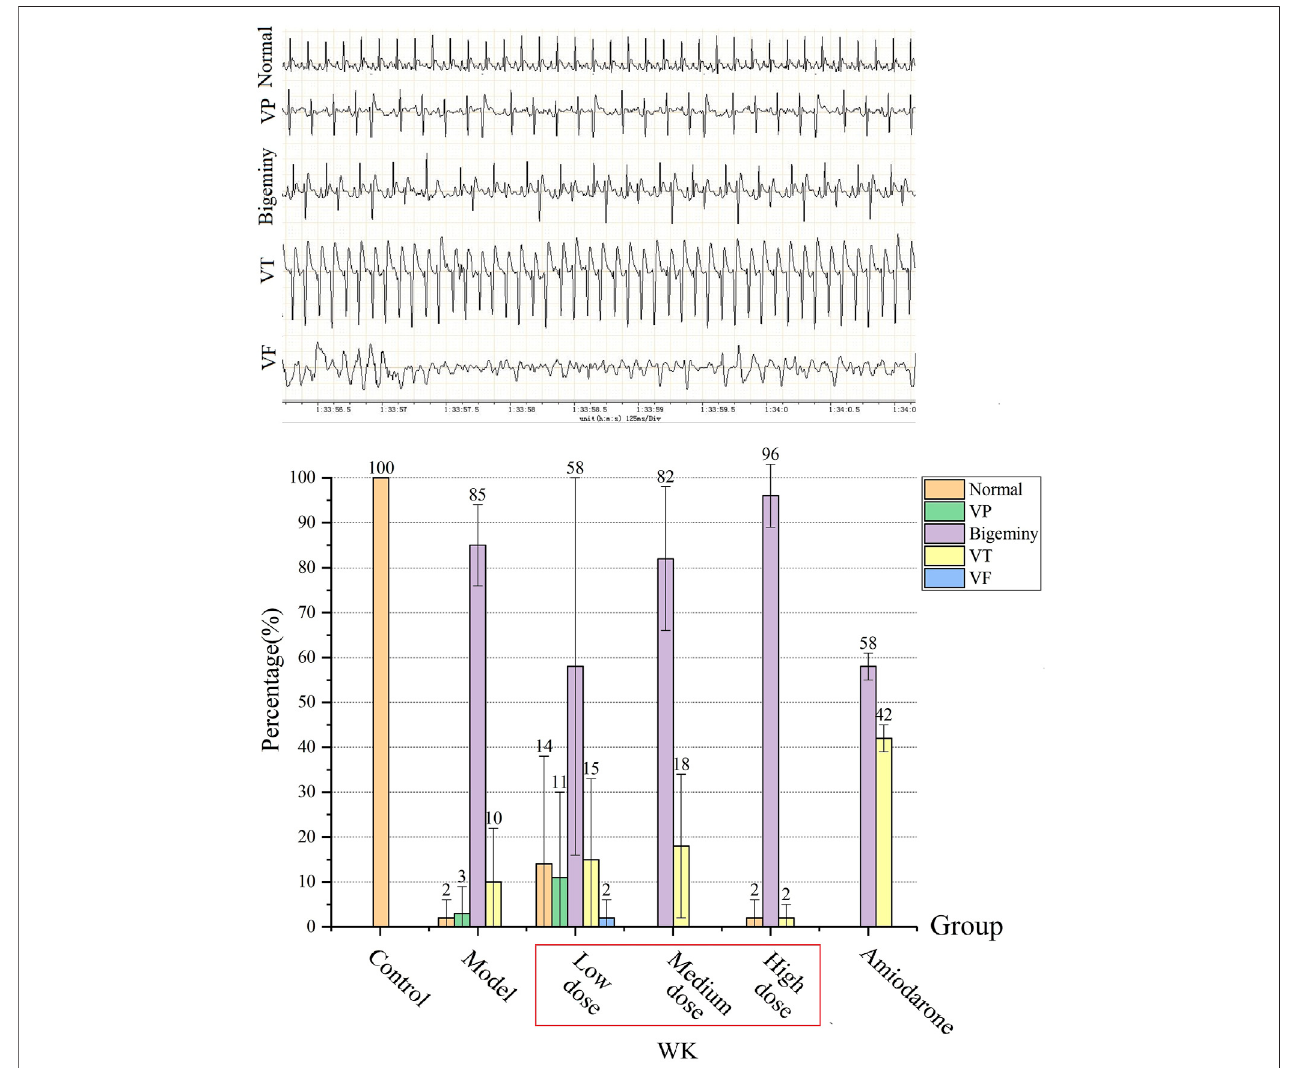
FIGURE 5 | The percentage of arrhythmias ’ duration (%) ( x ± s , n (cid:1) 8). VP: ventricular premature, VT: ventricular tachycardia, VF: ventricular fi brillation.